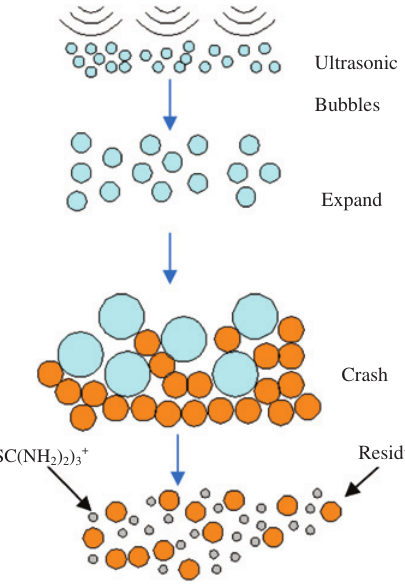
Figure 13: Sketches of mechanism of ultrasound-assisted leaching of Ag from